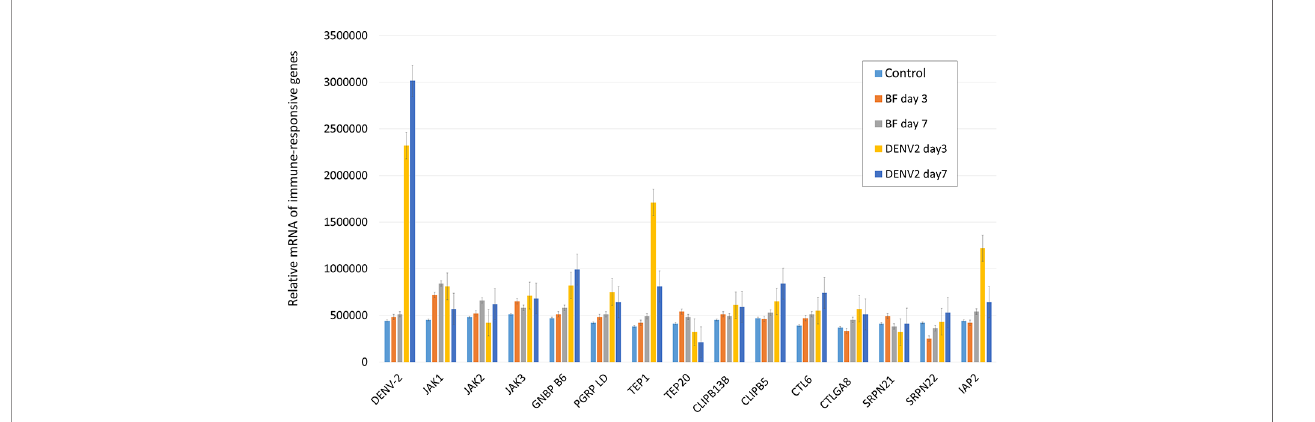
FIGURE 1 | Transcriptional Analysis of Immune-Responsive Genes in the Mosquito Midgut. The relative mRNA levels of the immune-responsive genes from three and seven days after normal (BF) and infectious DENV2 blood-fed (DENV2) mosquito midguts were examined with qRT-PCR analysis. Midguts of mosquitoes fed with non-infectious blood were used as controls. An equal amount of total RNA from each group was used for cDNA synthesis. Ribosomal protein S7 was used for normalization of relative target gene mRNA expression. Values are mean ± S.E. (error bars) of the copy number of each gene. At least three biological cohorts from each time point were used for